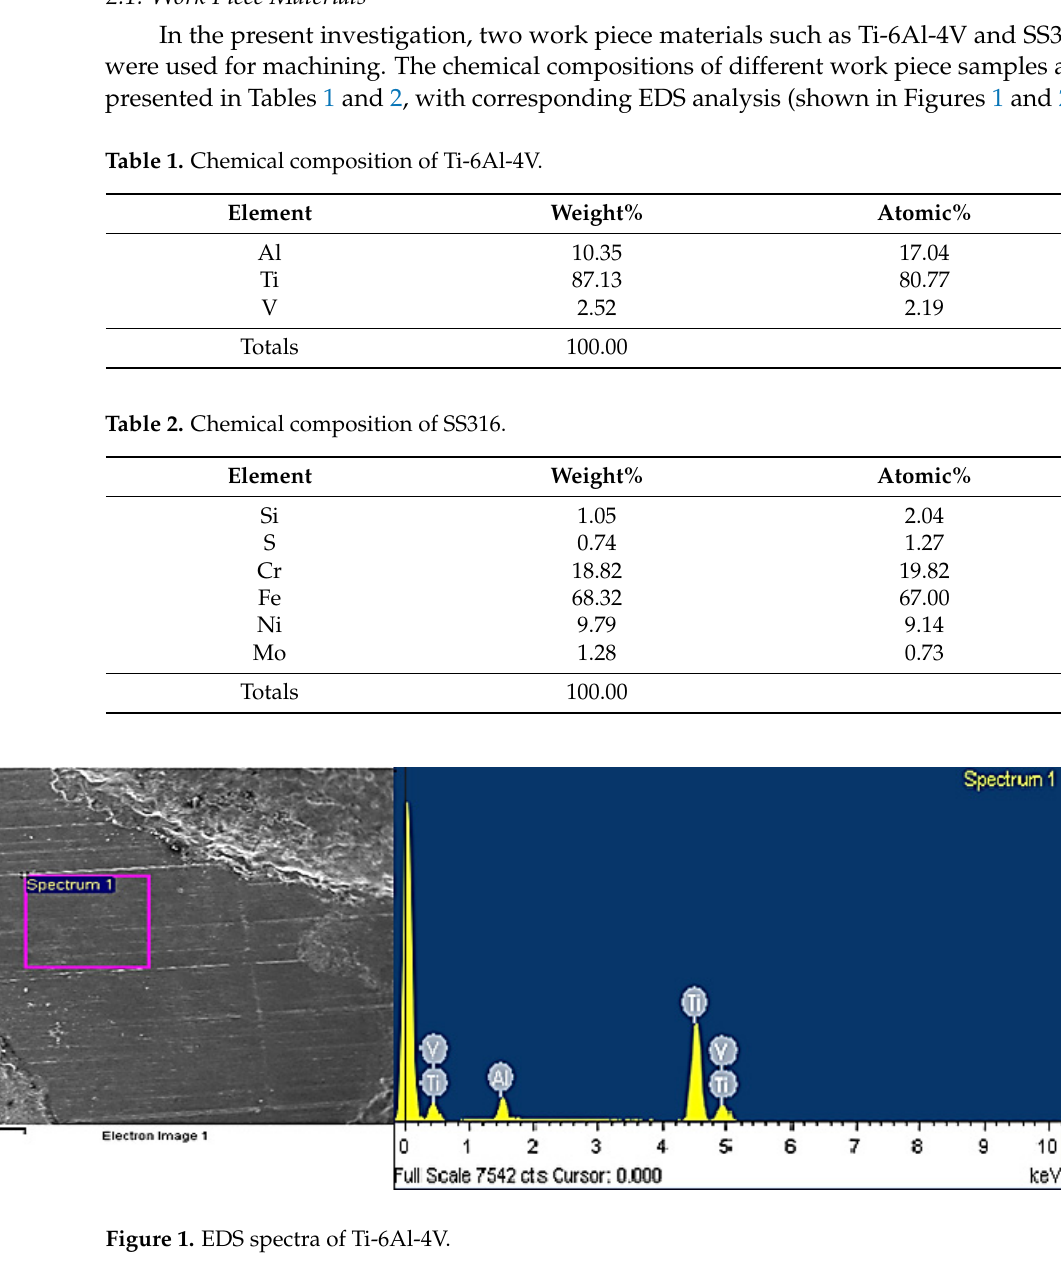
Figure 2. EDS spectra of SS316. Table 1. Chemical composition of Ti-6Al-4V. Element